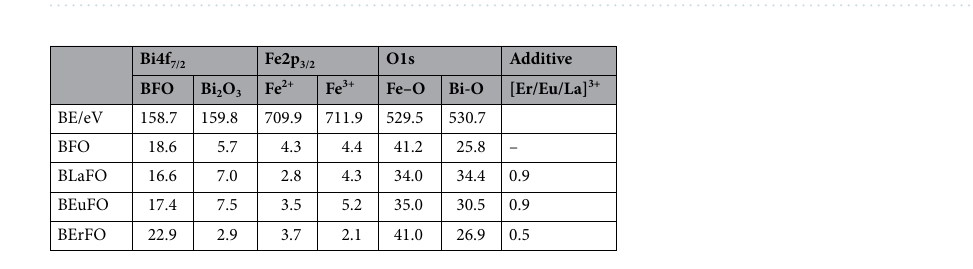
Table 1. The share of various chemical states of Bi, Fe, O, and rare-earth additives, based on high-resolution XPS analysis and spectral deconvolution. Results in at.%.